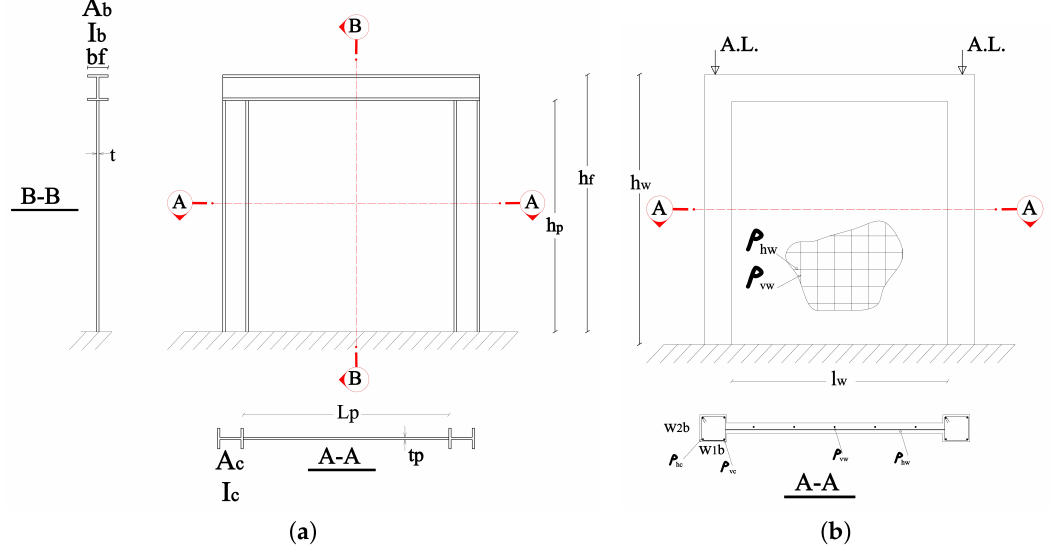
Figure 1. Dimensions of a generic shear wall. ( a ) SPSW, ( b )